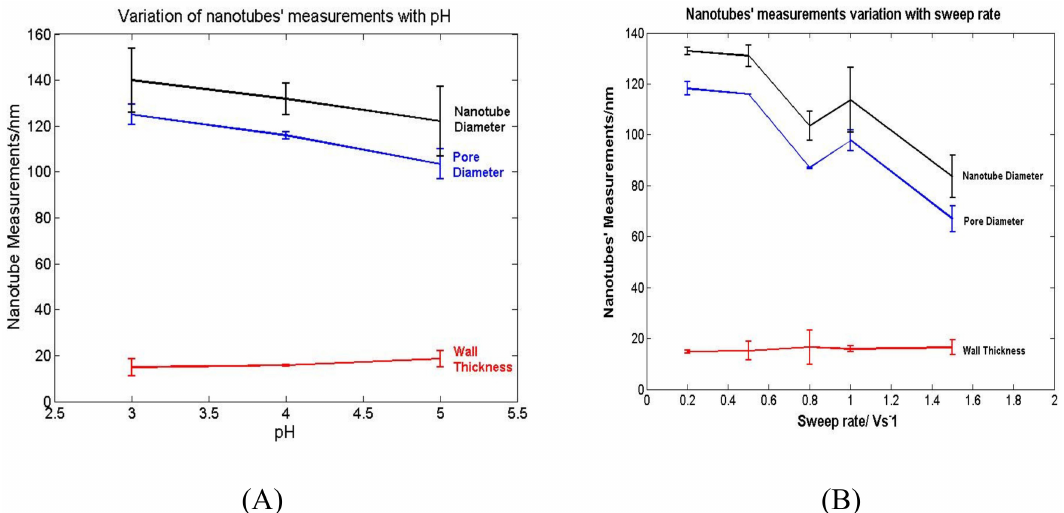
Figure 10. Variation of nanotubes dimensions with respect to ( A ) pH and ( B ) sweep rate. Reproduced with permission from Danookdharree et al., The E ff ect of Initial Etching Sites on the Morphology of TiO2 Nanotubes on Ti-6Al-4V Alloy; published by IOP, 2015,